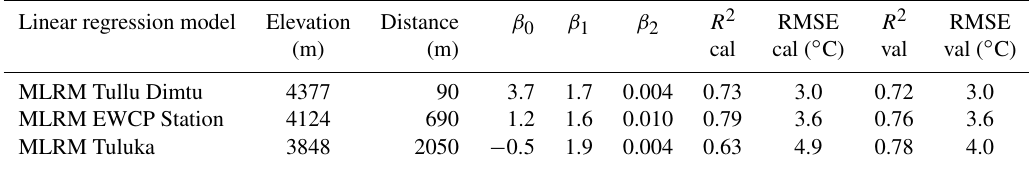
Table E1. Coefficients and goodness of fit of the three established multiple linear regression models (MLRMs) with ground temperature as dependent and air temperature and global radiation as explanatory variables. Distance means the distance between the AWS and ground temperature data logger, β 0 is the intercept, β 1 is the air temperature coefficient, and β 2 is the incoming shortwave radiation coefficient. Linear regression